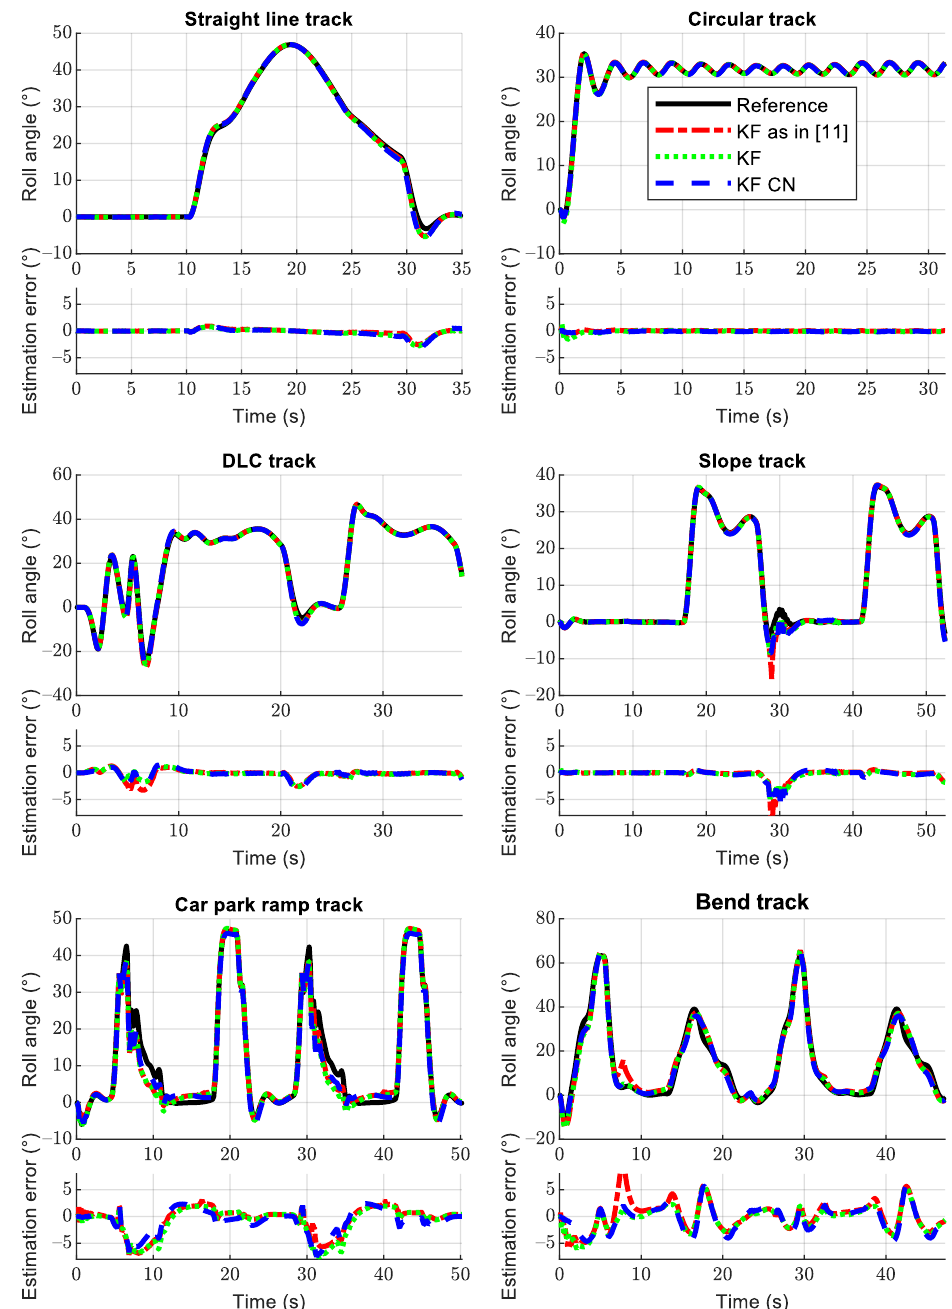
Figure 8. Estimated roll angle and roll angle error for the six different scenarios. All of these tests were performed with the rider in a neutral position. The reference is the black solid line, the red dash dotted line is the Kalman filter as presented in [11], the green dotted line is the variation of that Kalman filter presented here, and the blue dashed line represents the Kalman filter adapted for colored